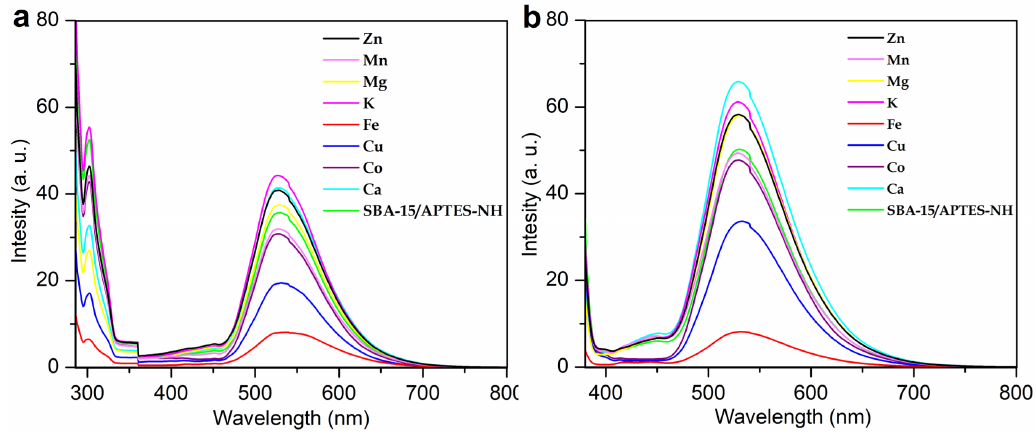
Figure 3: Emission spectral changes of the hybrid material SBA-15/APTES-NH with excitation wavelengths at (a) 276 and (b) 370 nm after sensing various metal ions.